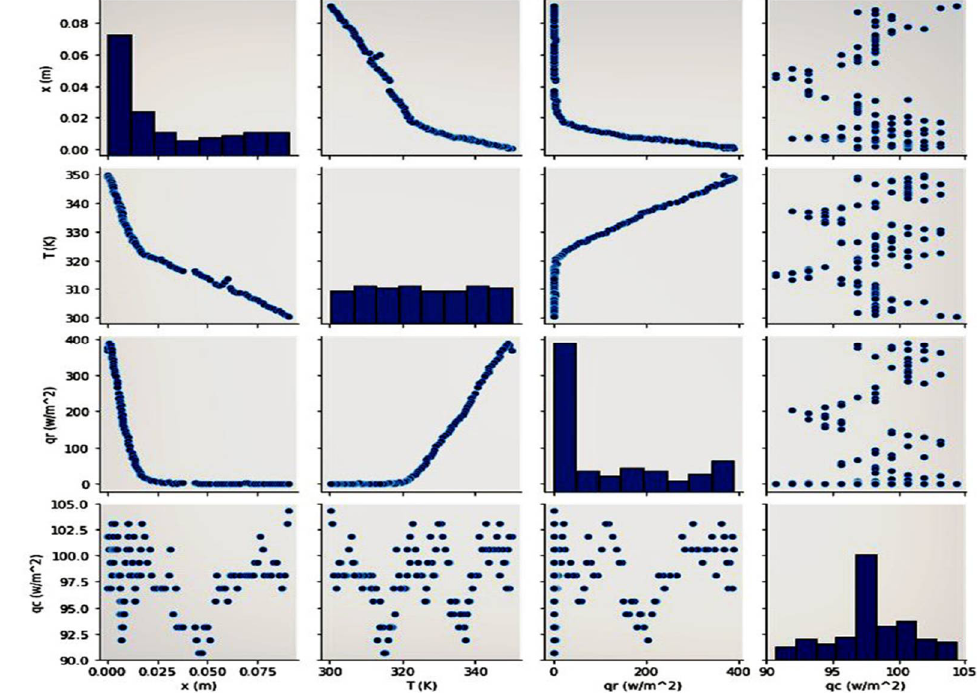
Figure 8. The scatter plot of different heat transfer parameters.